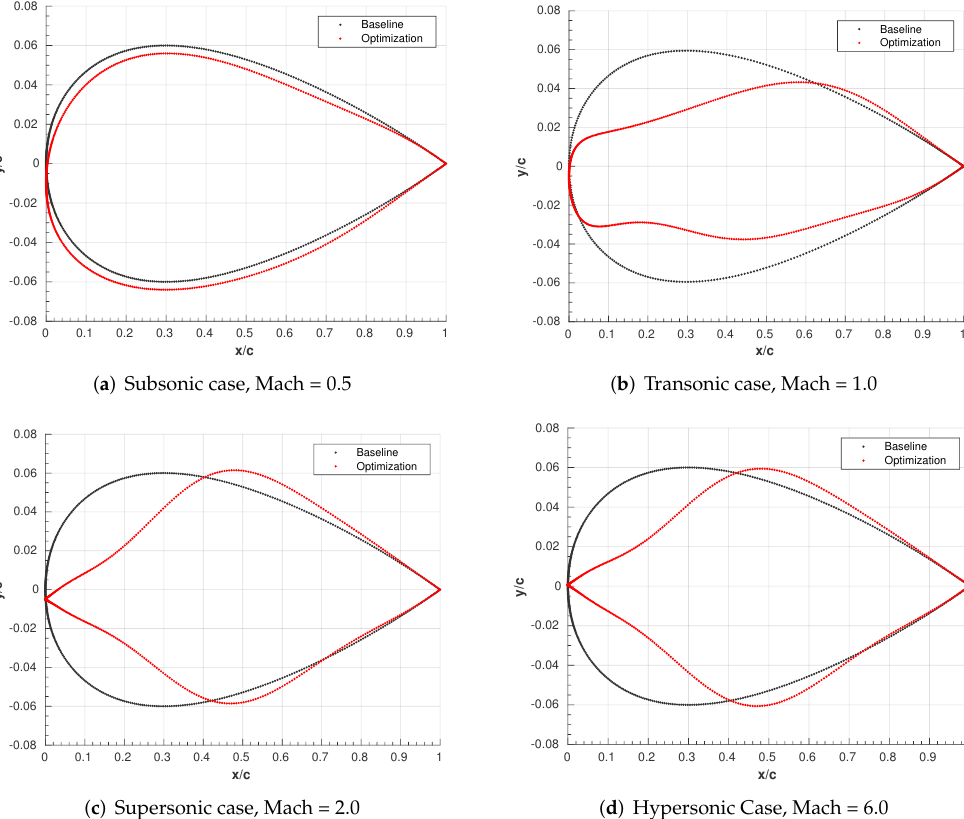
Figure 10. Comparison between baseline and optimized airfoil shapes. ( a ) Subsonic case, Mach = 0.5. ( b ) Transonic case, Mach = 1.0. ( c ) Supersonic case, Mach = 2.0. ( d ) Hypersonic Case, Mach = 6.0. Furthermore, there is a displacement of maximum thickness towards the back of the airfoil. Finally, in both the supersonic (Figure 10c) and hypersonic (Figure 10d) results, the optimal design greatly differs from the baseline one. The region comprising the leading edge is pulled inwards, significantly decreasing the LE radius. In addition to that, the position corresponding to the maximum thickness is moved from x / c = 0.3 to x / c ≈